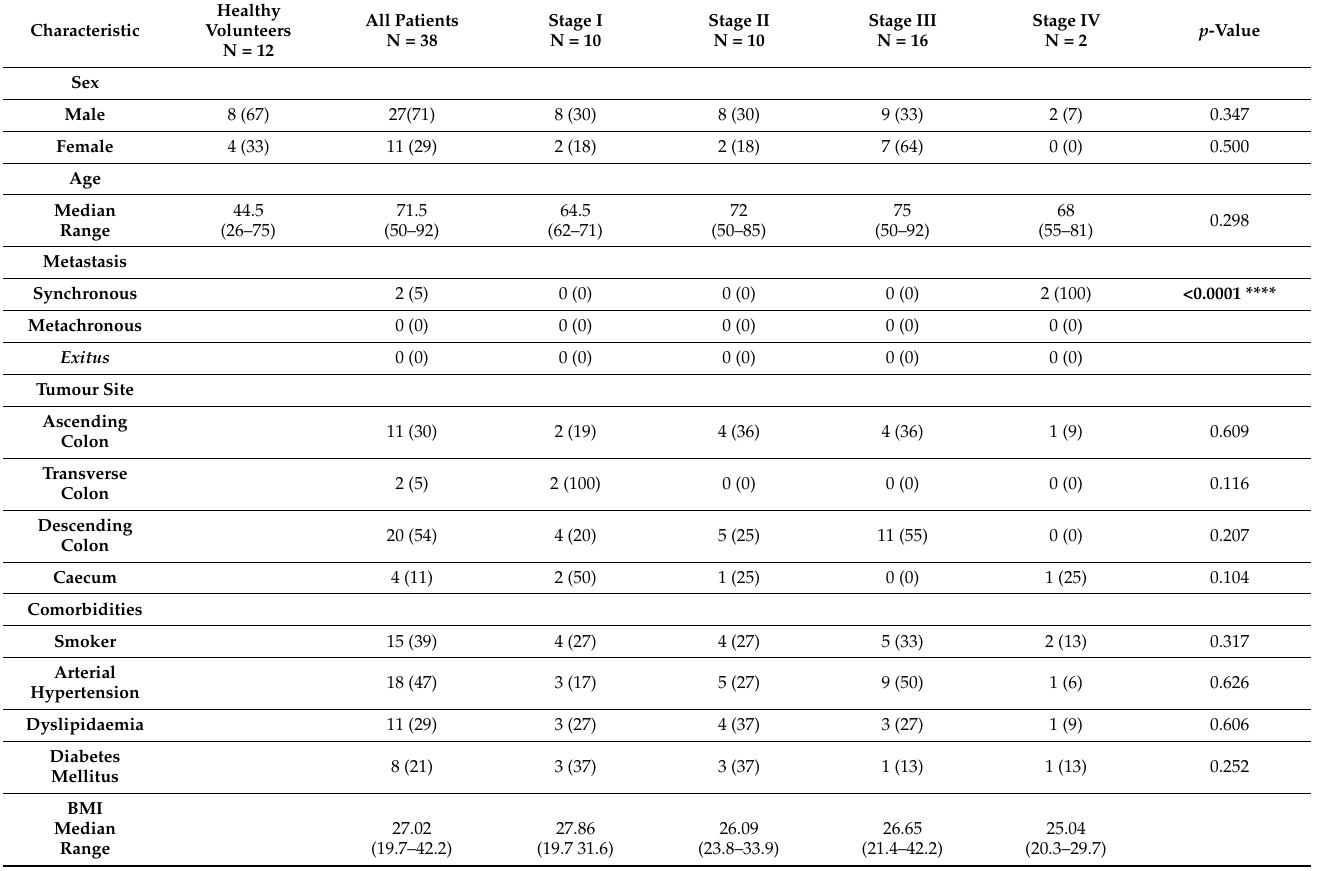
Table 2. Prospective Patient’s Cohort Characteristics 1